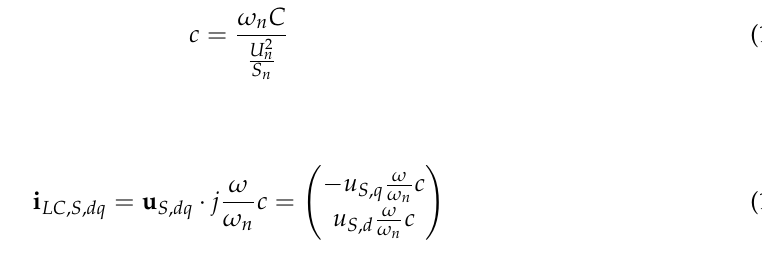
Figure 3. Cascaded voltage- and current control of Figure 1 (R of Equation (11) is neglected). In order to improve clarity, the connection between u S , d and i S , q each from voltage control to current control are not shown directly but indicated in blue 1 + , ref for the voltages and in red for the